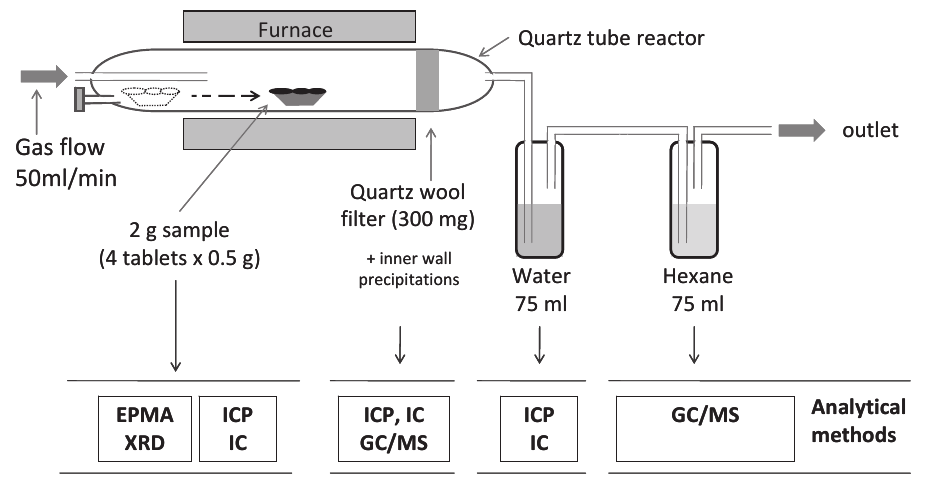
Figure 1. Schematic of the experimental set-up for the furnace and overview of the analytical procedures used. sourced from waste polyvinyl chloride (PVC) for selec- tive chlorination and evaporation of zinc [5–12].